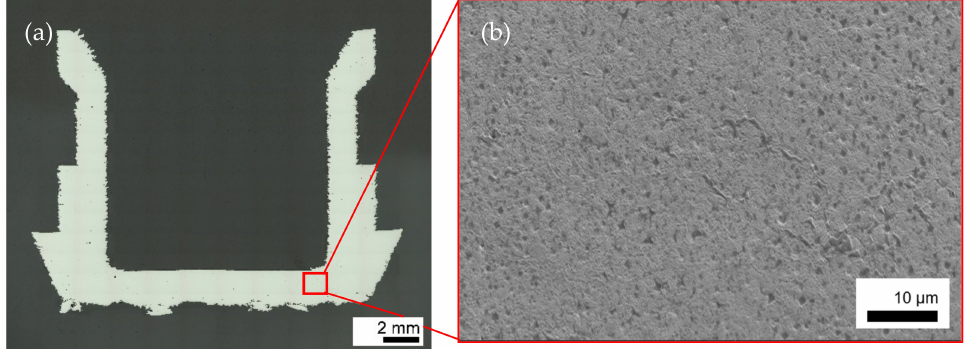
Figure 4. Cross section ( a ) and corresponding SE image ( b ) of the open thin-walled cylinder present- ing a nearly dense and crack free as built